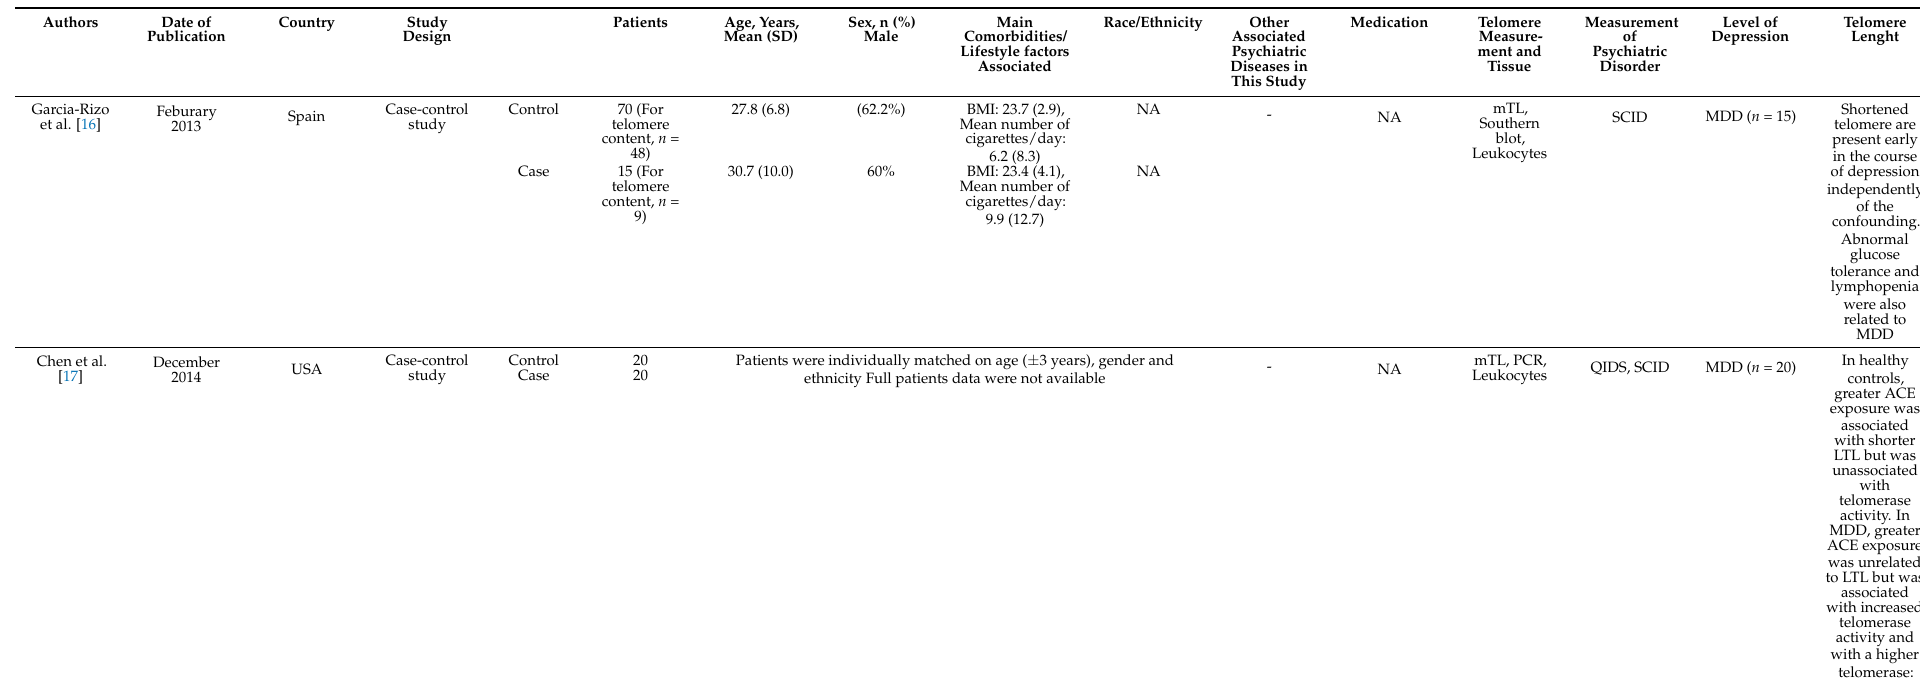
Table 1. Study characteristics, clinical and epidemiological data analysis of depressive disorders impacts on telomere